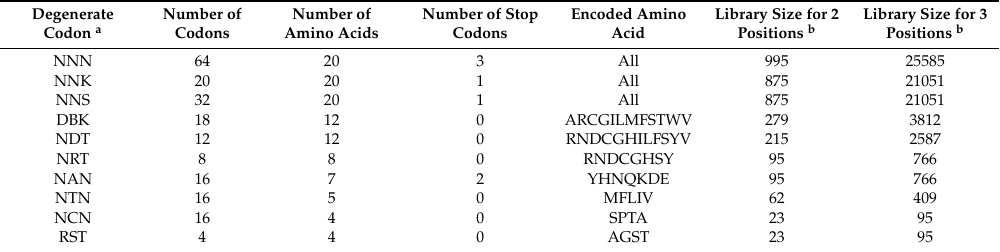
Table 1. Analysis of some codons used for saturation